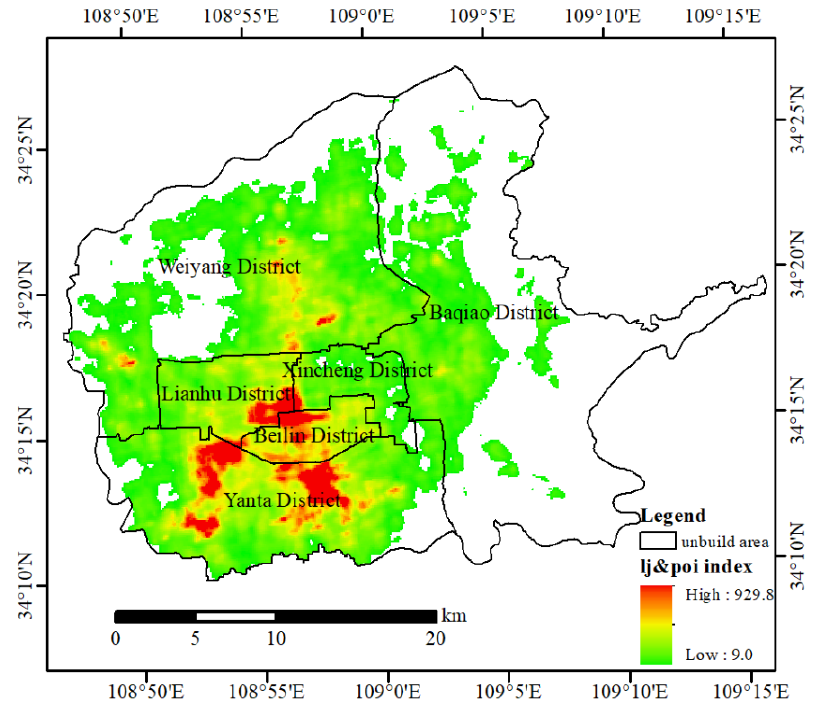
Figure 5. Spatial distribution of the LJ&POI index.